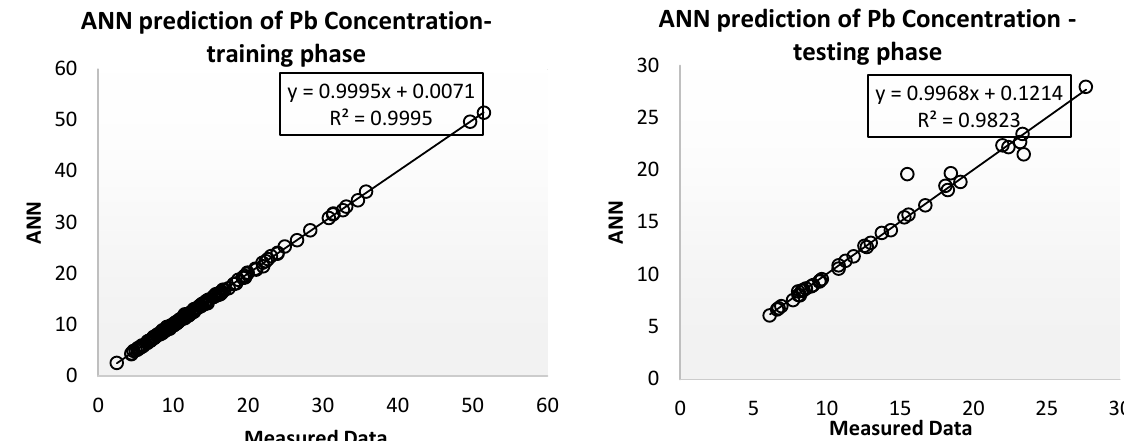
Figure 7. Scattered plot of predicted with actual values for Pb in training (left) and testing (right) phases ANN: Artificial neural